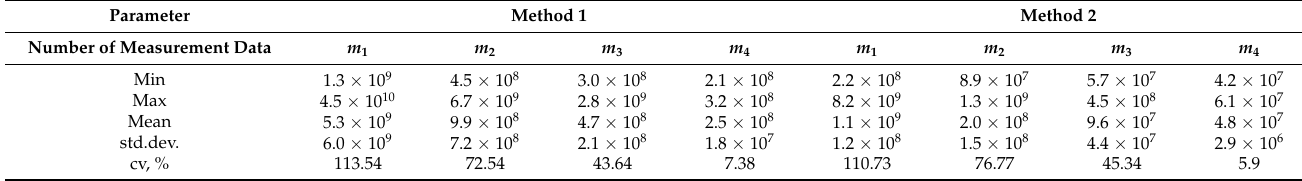
Table 4. Condition number cond( G ) for load level V 1.5